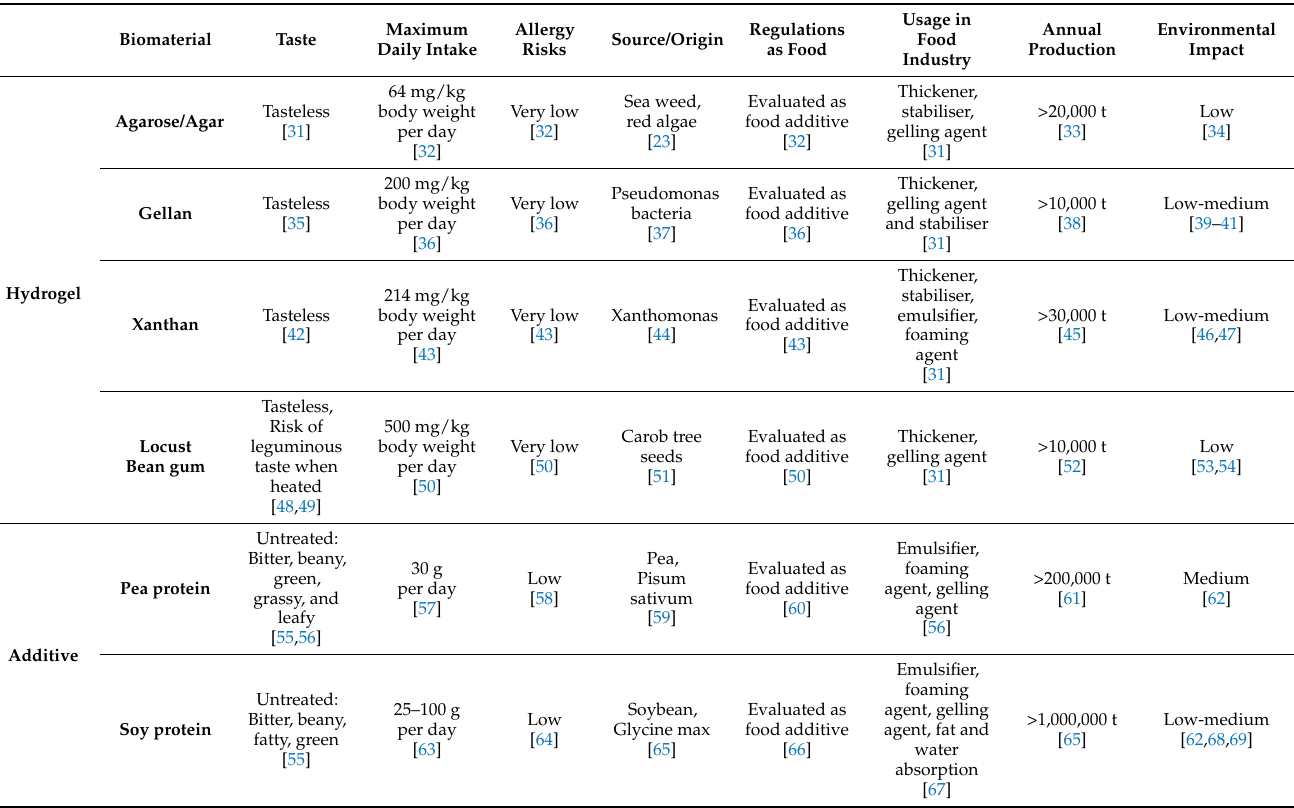
Table 1. Food and environmental characteristics of the biomaterials agarose, gellan, xanthan, locust bean gum, soy and pea